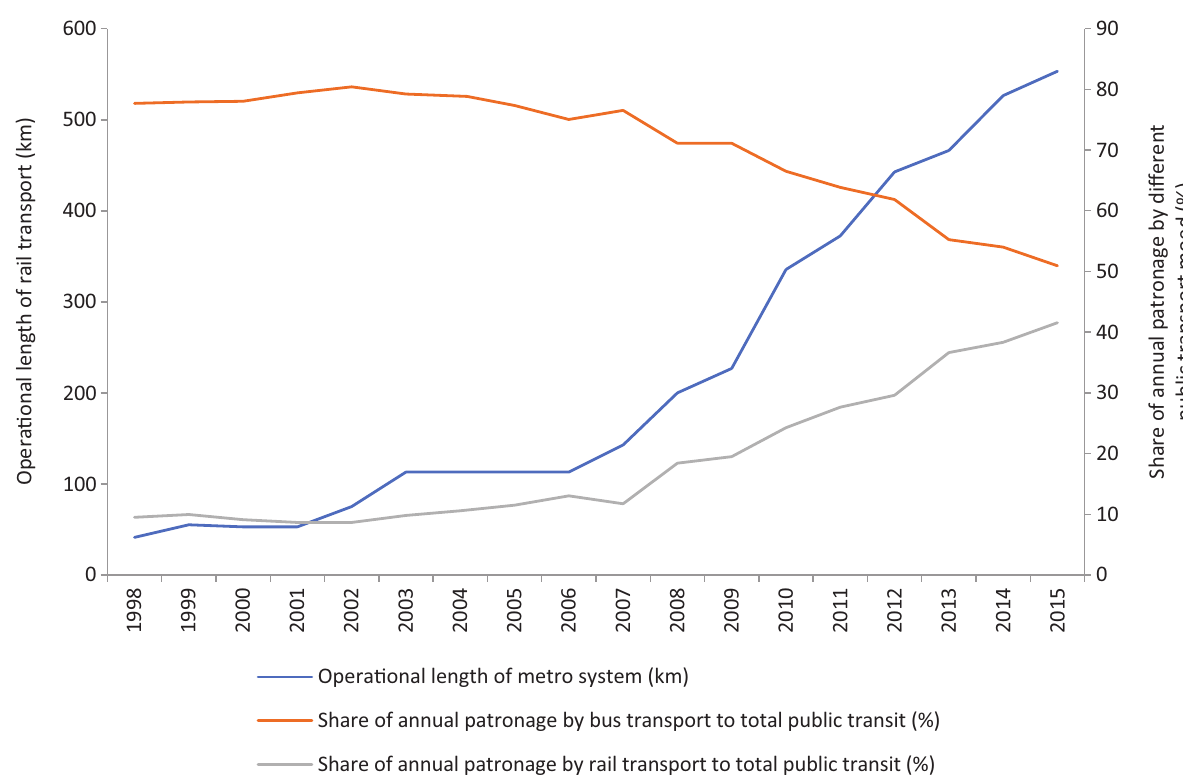
Figure 5. Operational length of rail transport and the share of annual patronage by rail transport to total public transport modes in Beijing (including rail transport, taxi, bus and trolley bus). Source: Compiled based on data provided by the